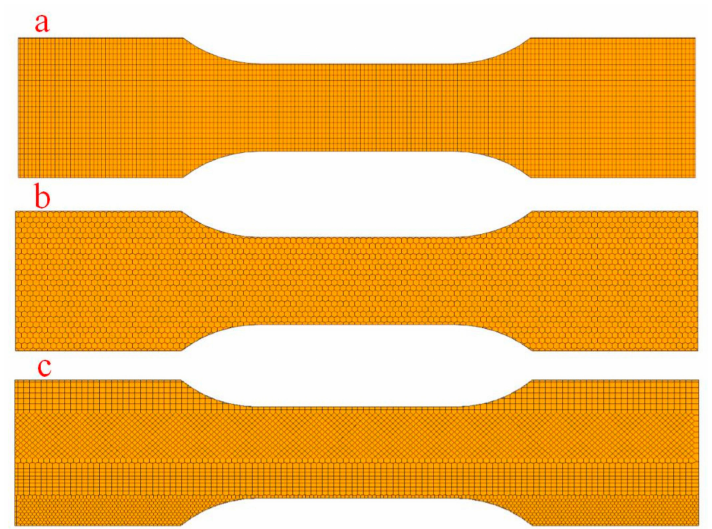
Figure 6. Three-dimensional models of different bionic fatigue specimens: ( a ) quadrilateral bionic pit fatigue specimen; ( b ) hexagonal bionic pit fatigue specimen; ( c ) irregular and disorderly pit fatigue